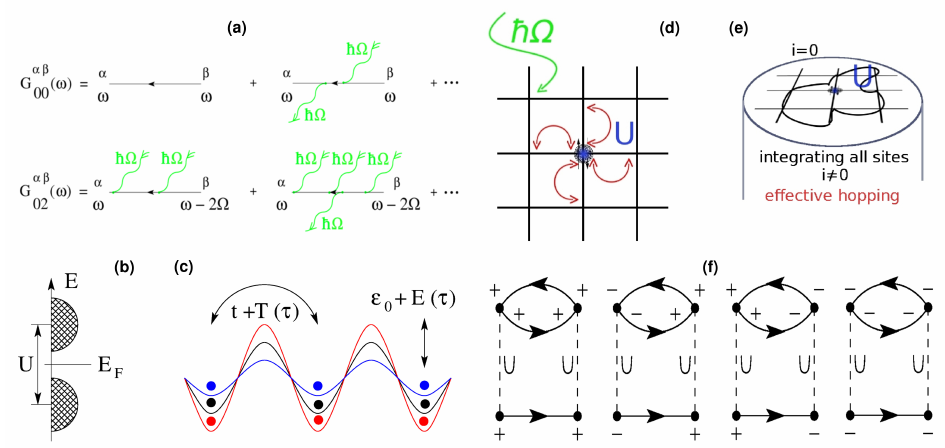
Figure 2. Theoretical setup ( a ) Floquet expansion of the Green’s function G into higher harmonics of ¯ h Ω L . ( b ) Hubbard model of the electronic system. The gap between bands is defined by the Coulomb interaction U symmetrically to the Fermi Energy E F . ( c ) Tight binding system of the crystal lattice. The hopping parameter t is renormalized by external time dependent excitations T ( τ ) . ε 0 + E ( τ ) are renormalizations of the local potential alone; ( d ) non-equilibrium DMFT. Pump photons ¯ h Ω L enhance electronic hopping which is mapped on the single site on the background of the surrounding identical lattice sites, the bath. ( e ) integration over all sites yields an effective self-consistent theory including non-equilibrium effects. The electronic system is coupled to Mie resonances; ( f ) diagrammatic contributions of the second order